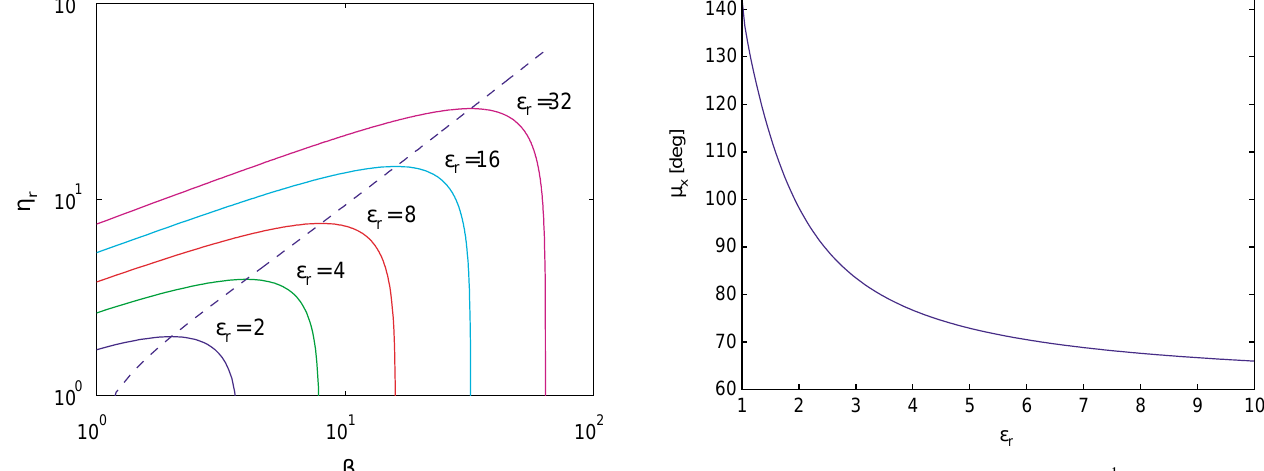
FIG. 3. (Color) Horizontal phase advance per 1 function of the emittance detuning factor ´ r